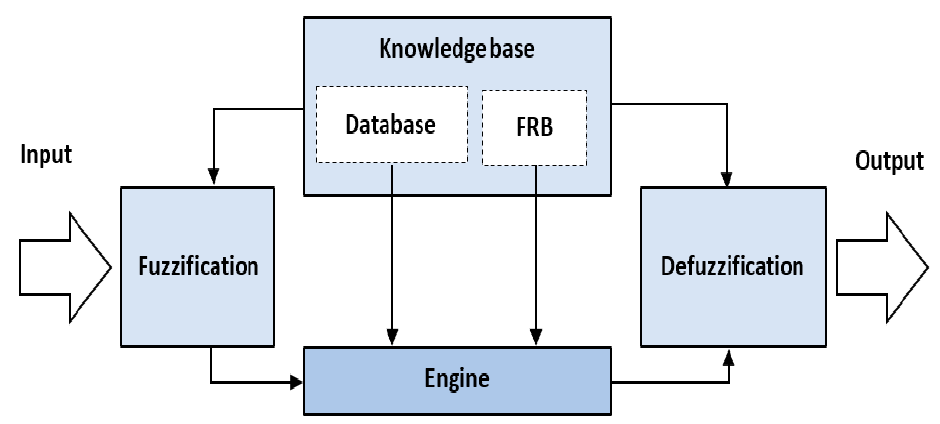
Figure 1. The general framework of the FIS.